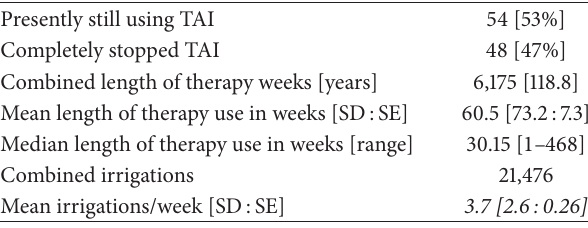
Table 2: Transanal irrigation (TAI) therapy use .